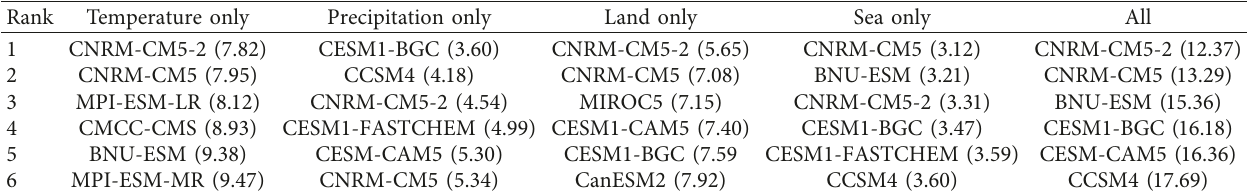
Table 4: List of the six global climate models performing best for different categories, including temperature only, precipitation only, land only, and sea